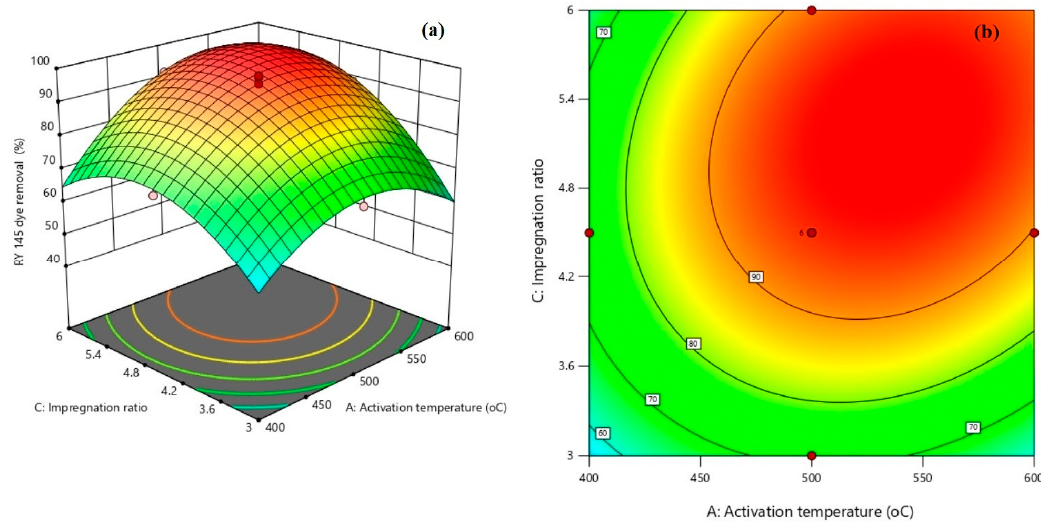
Figure 5. Response surface plots for the effects of H 3 PO 4 used and activation temperature on the 3D response ( a ) and its corresponding counter plot ( b ).